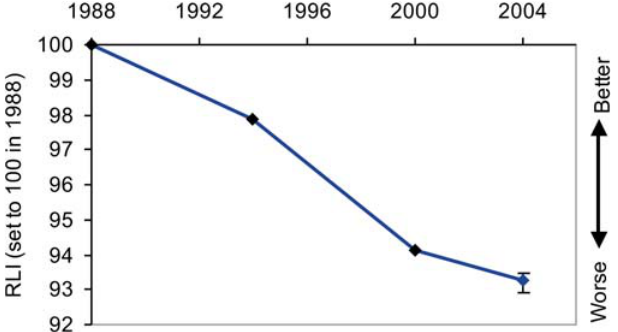
Figure 3. The RLI for All Bird Species with Categories Weighted by Relative Extinction Risk Sample size: 250 genuine status changes/2,469 species in categories Extinct in the Wild to Near Threatened in at least one assessment. Error bars for 2004 RLI value based on estimated number of genuine status changes for 2000–2004 not yet detected owing to information time lags (see Materials and Methods for further details). DOI: